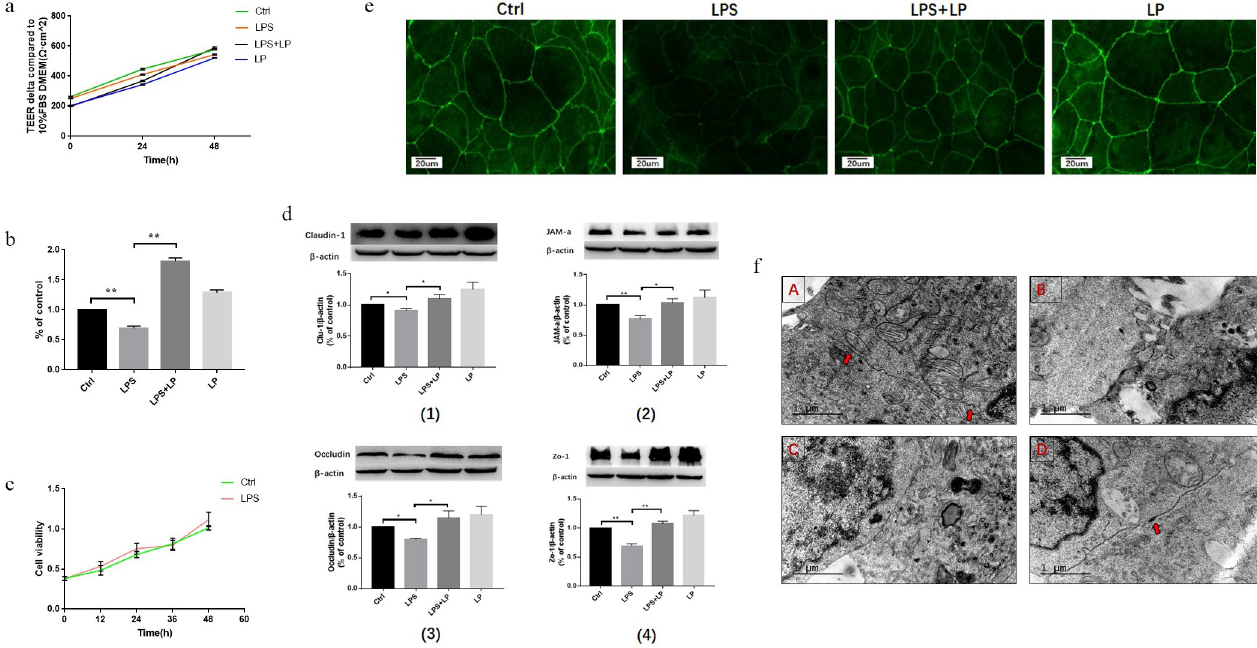
Fig 2. Measurement of TEER at 0, 24, and 48 h by each cell resistance meter (a) and TEER changes of each group at 24–48 h (b), Data are presented as the mean ± SD. three independent experiments were performed in duplicate. �� P < 0.01 LPS + LP group vs. LPS group. (c) Effect of LPS treatment for 48 h on cell viability. (d) WB detection of claudin-1, JAM-a, occludin, and Zo-1 expression levels. Data are presented as the mean ± SD. four independent experiments were performed in duplicate. � P < 0.05 LPS + LP group vs. LPS group, �� P < 0.01 LPS + LP group vs. LPS group. (e) Immunofluorescence detection of ZO-1 tight junction protein expression and distribution. three independent experiments were performed in duplicate. (f) Changes in electron microscopy-observed tightly connected cellular ultrastructure between groups. Arrows indicate the tight connection of Caco2 cells in each group A: Ctrl group, B: LPS group, C: LPS + LP group, D: LP group. three independent experiments were performed in